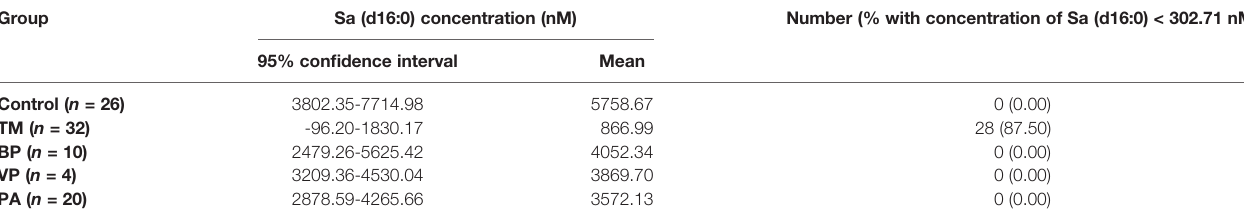
TABLE 2 | Serum concentration of Sa (d16:0) in healthy controls, and patients with T. marneffei infection (TM), bacterial pneumonia (BP), viral pneumonia (VP), and pulmonary aspergillosis (PA). Group Sa (d16:0) concentration (nM) Number (% with concentration of Sa (d16:0) < 302.71 nM) 95% con fi dence